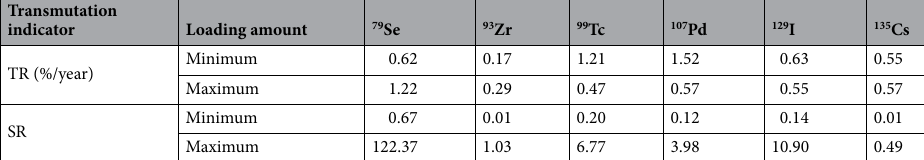
Table 6. The TR and SR values were obtained from different LLFPs composition schemes. The minimum load results are obtained by averaging the TR (or SR) values obtained from the other five LLFPs composition schemes.